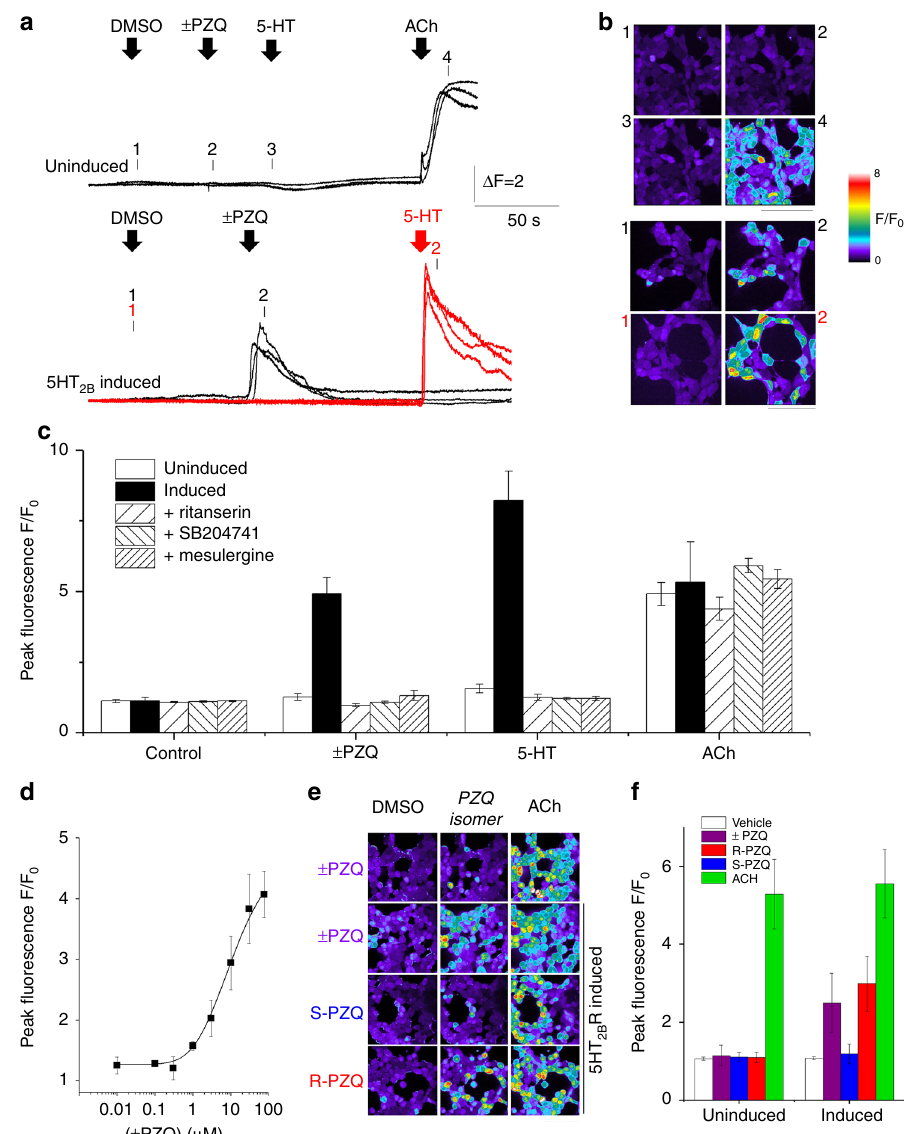
The debilitating impact of schistosomiasis results from the host ’ s immune response to schistosome eggs, deposited in proli fi c numbers in the liver, intestine and/or bladder where they elicit granulomatous in fl ammation, periportal fi brosis and hyperten- sion 2 . Clinical outcomes span gastrointestinal and liver patholo- gies, genitourinary disease, anemia, malnutrition, and a heightened risk for comorbidities and HIV transmission. The associated disease burden encumbers third world economies with an annual loss of up to 70 million disability-adjusted life years 4,5